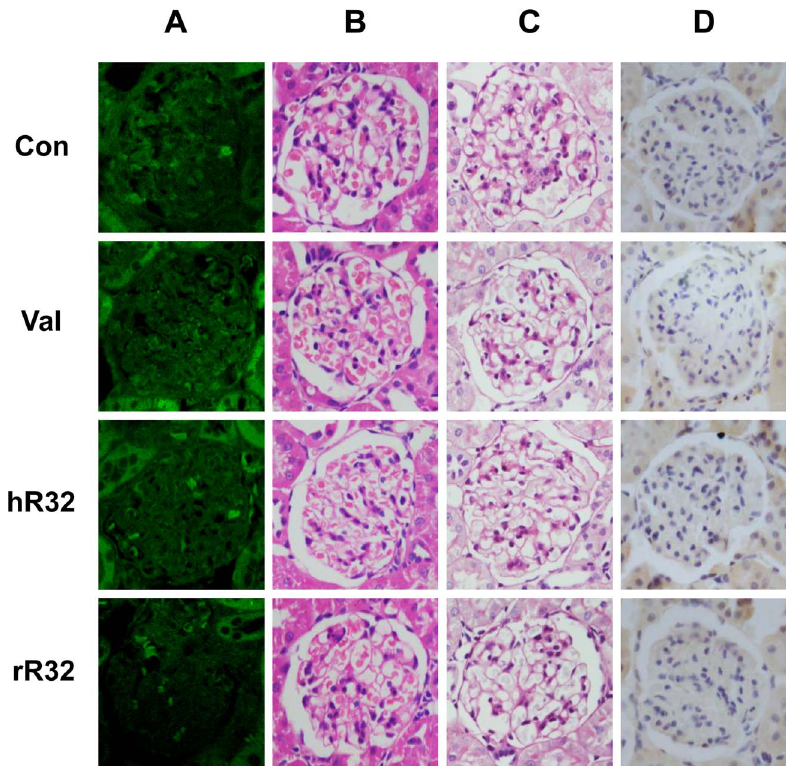
Figure 5. The histological safety assessment in SHRs vaccinated with R32 vaccines. A–D. The representative kidney images were observed under light microscopy on week 18. A. Compared with the control group, the IgG deposition in the kidney was not detected by immunofluorescence. Both HE ( B ) and PAS ( C ) staining showed no obvious cells proliferation and pathological changes in the mesangial region of the vaccine groups. D. The immunohistochemical staining against CD14 indicated no excessive activation and infiltration of macrophages in the